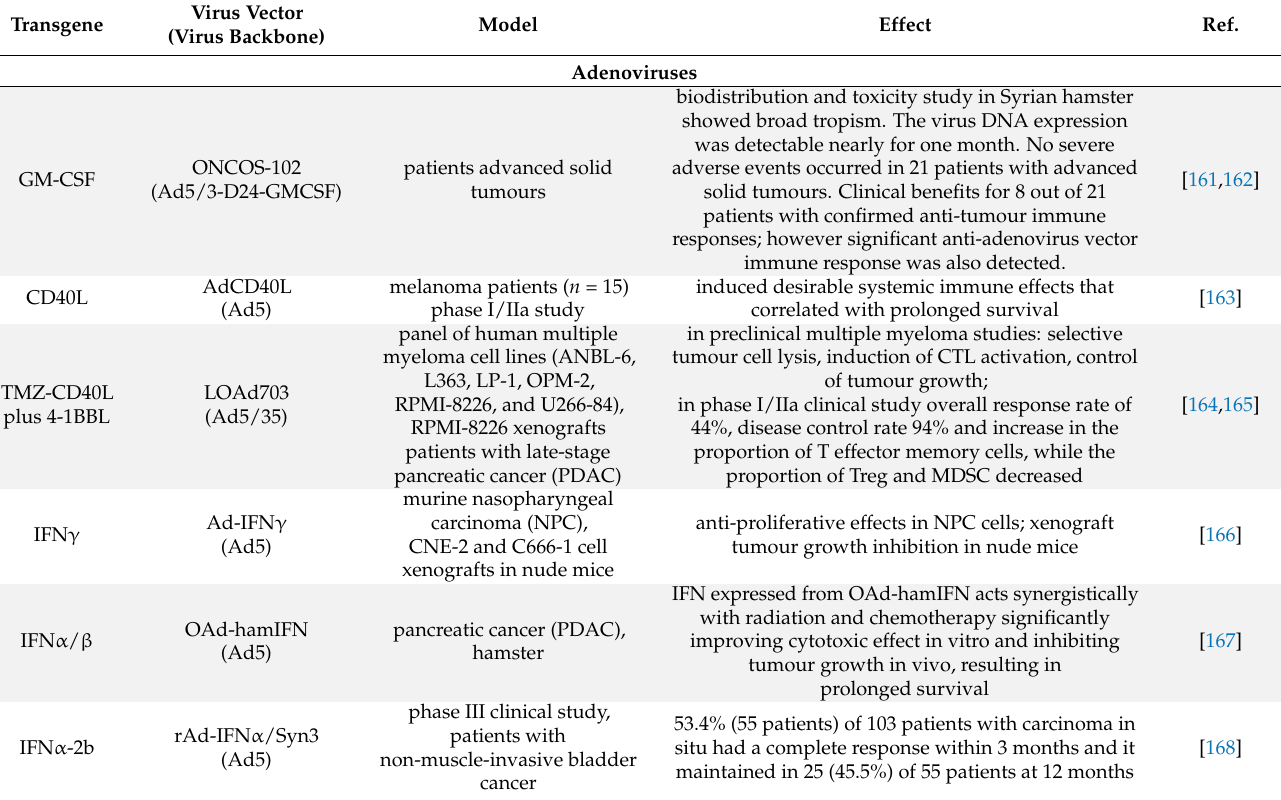
Table 2. Virus vectors encoding cytokines and other molecules activating DCs and